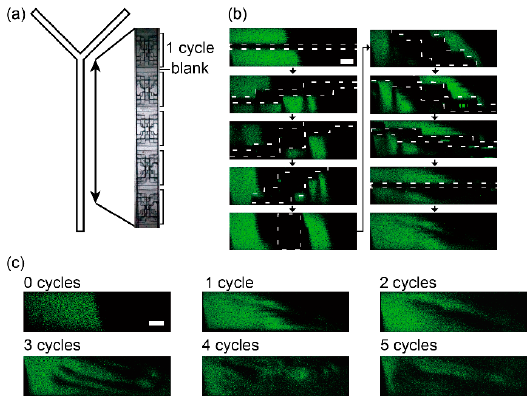
Figure 4. Confocal microscope images of a flow in the spiral structure channel. ( a ) Overhead view of the Y-shaped channel with the 5 spiral structures; ( b ) Confocal microscope images of vertical cross